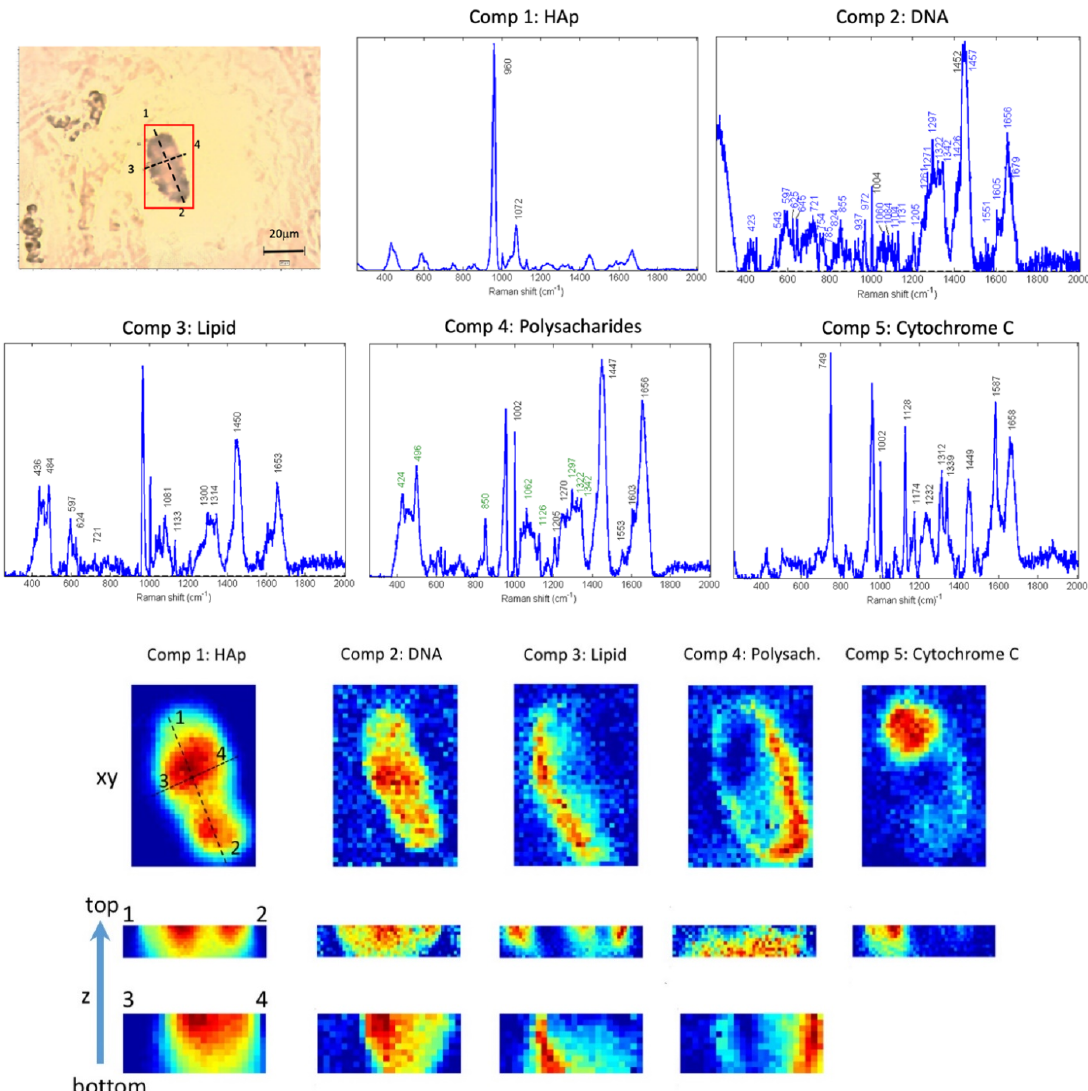
Figure 2. Raman spectral images show the presence of different molecular components in HAp tissue calcifications. Top left: Bright field image of a breast tissue section with a HAp calcification highlighted in the region of interest (red box). Raman images were taken from this area. Using the MCR algorithm, several molecular components were deconvolved from the spectra. In the first and second rows, the spectral signatures of the deconvolved molecular component are shown. For each component, its corresponding abundance maps are plotted in the bottom half of the Figure. The last two rows are perpendicular sections imaged to show the distribution of the molecules in depth inside the tissue. This microcalcification was found in tissue number 20 of Table 1. The assignment of bands for the different components was performed based on our constructed database and the literature [40–43].